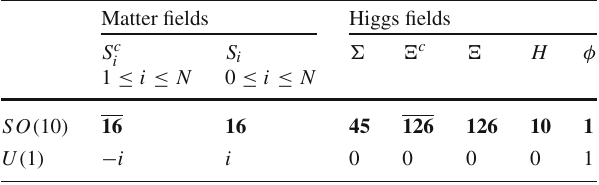
Table3 Fieldcontentandsymmetriesofthe SO ( 10 ) model.Allmatter fields ( S i , S c ) carry an additional generation index (not shown) i Matter